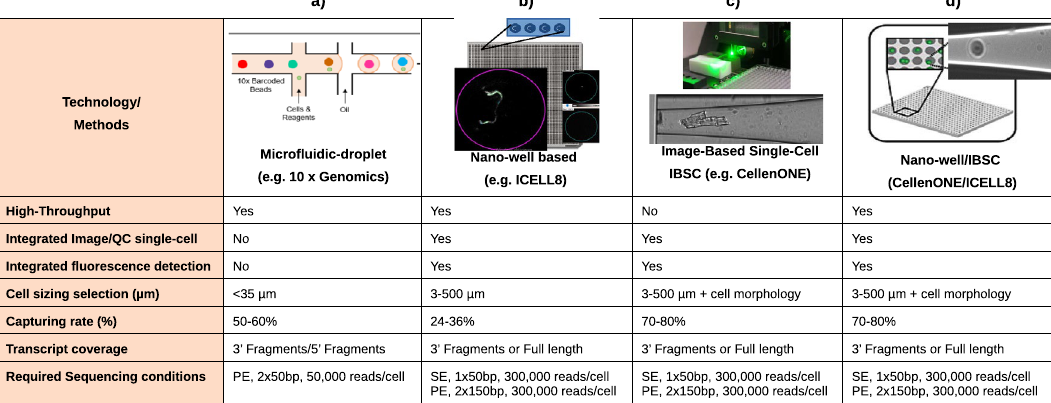
Figure 1. Technical information of state-of-the-art integrated platforms for single-cell RNA-Sequencing. Methods used in each of the platforms for single-cell isolation, barcoding, chemistry and sequencing. ( a ) the 10× Genomics Chromium ( b ) the ICELL8 cx Single-Cell system; ICELL8 ( c ) the CellenONE X1 system, CellenONE and ( d ) advantages of the combined CellenONE X1 and iCELL8 cx Single-Cell systems,